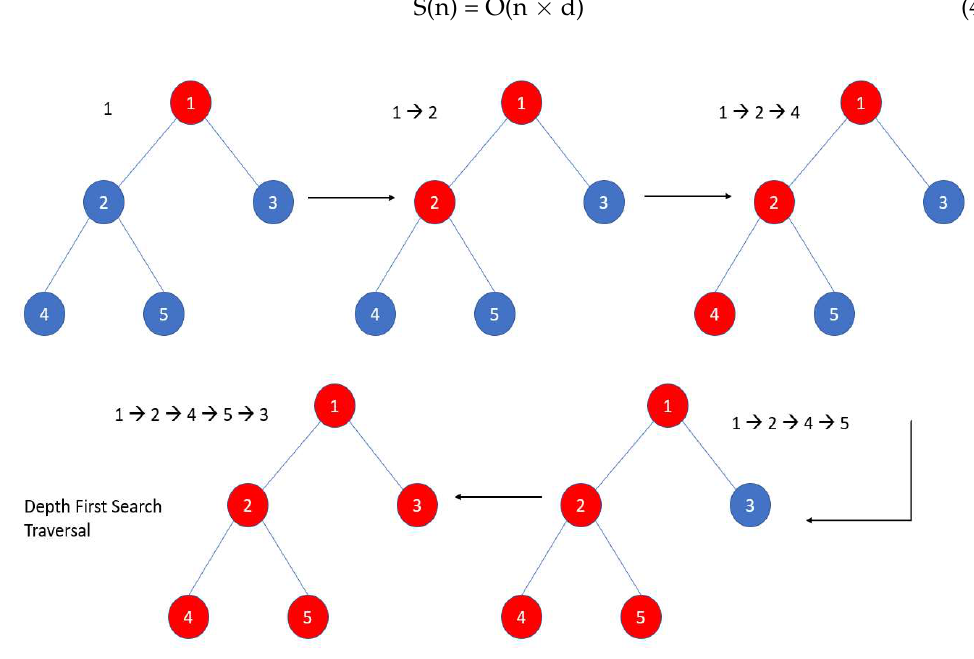
Figure 6. Depth first search traversal.